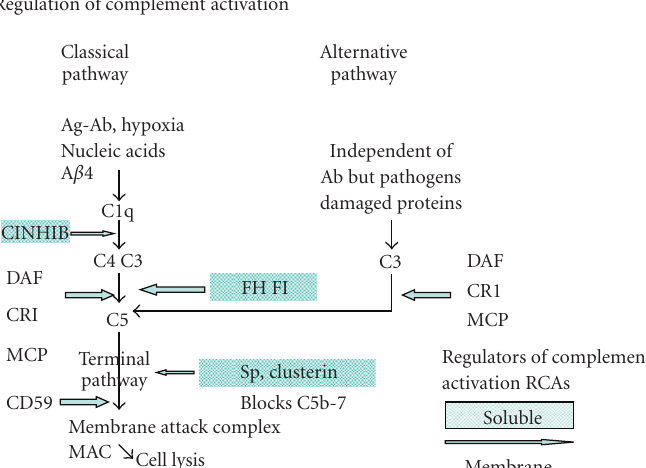
Figure 2: This figure shows a summary of the individual components of the classical and alternative complement pathways (CP), both converge at the C3/C5 step and share a common terminal pathway with eventual generation of the cytolytic protein, membrane attack complex MAC. The membrane bound complement regulatory proteins (CRP) CRI (CD35), DAF decay accelerating factor (CD55), MCP (CD46), CD59 at the sites along the pathway where they inhibit C synthesis. The soluble CRP, C inhib, clusterin, Factor H (FH), Factor I (FI) are also